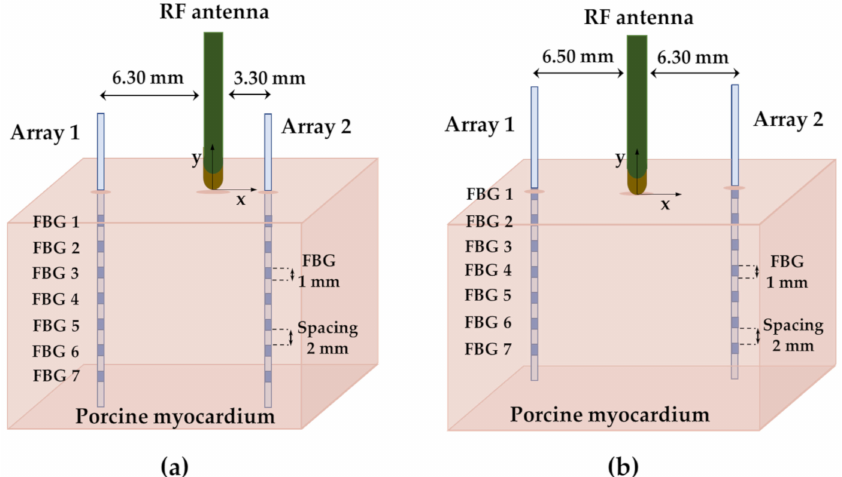
Figure 4. Schematic of the FBG sensors and RF antenna positioning in the myocardial tissue during the RF ablation process: ( a ) setting for the ablation performed at 50 W (Trial 1); ( b ) setting for the ablation performed at 60 W (Trial